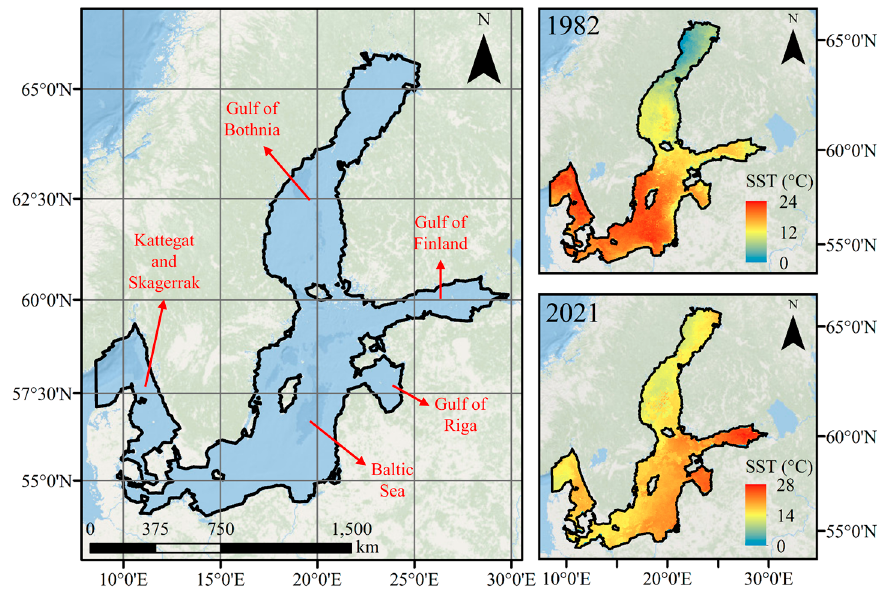
Figure 1. The geographical location of the study area, along with maximum sea surface temperature (SST) in 1982 and 2021 computed using high-quality AVHRR remote sensing data acquired at night.